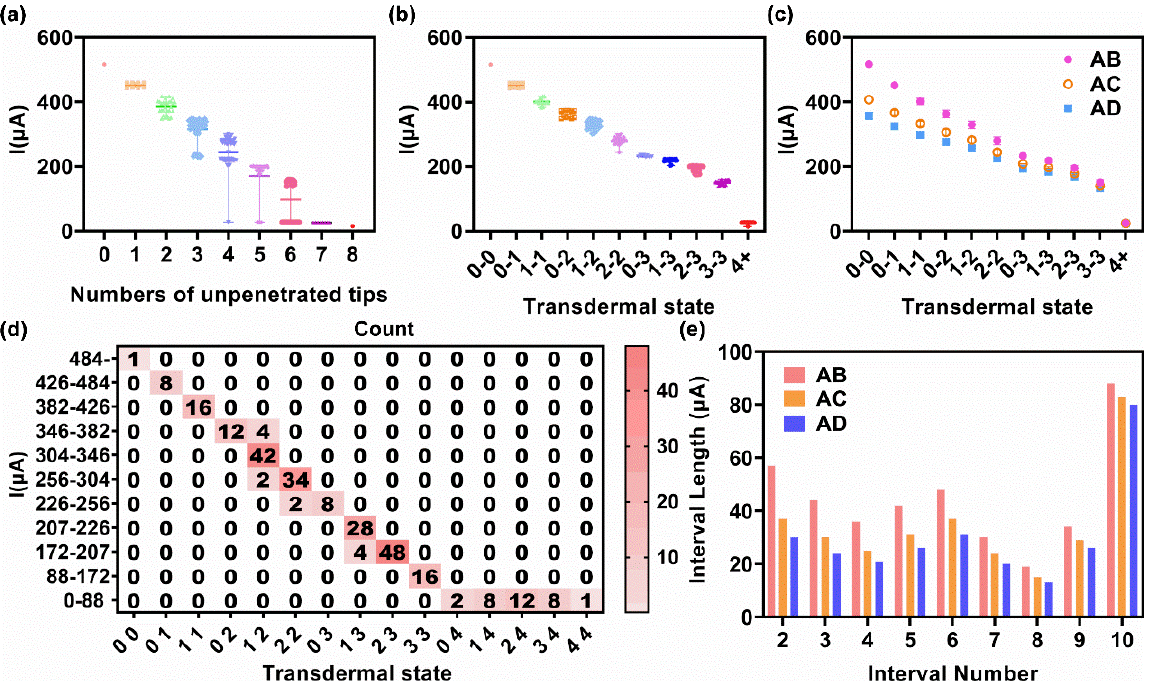
Figure 5. Simulation results of 4 × 4 microneedle array model, obtained from the statistical analysis of the terminal current after sweeping 256 transdermal events per pair of microneedle sheets. ( a ) The nested figure of the current distribution of A – B inter – sheet, divided by N total . ( b ) The nested figure of the current distribution of A – B inter – sheet, divided by transdermal state. ( c ) The statistical results of the test current against the transdermal state. ( d ) Heat map of the current interval against the transdermal state of A – B. Simulation results of 3 × 3 microneedle array model, obtained from the statistical analysis of the terminal current after sweeping 64 transdermal events per pair of microneedle sheets. The numerals in each cell referred to the count of transdermal events (e.g., 16 events were enclosed into the “1–1 state”). ( e ) Histogram of the interval length of each interval. The x – axis started at interval 2 on account that interval 1 was half – open. Table 2. The current interval division of the transdermal state of the 4 × 4 microneedle array model.